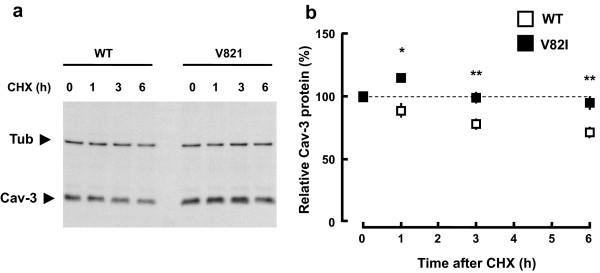
Stability of Cav-3 WT and Cav-3 V82I. Transfected BHK cells were treated with cycloheximide (10 μg/ml; CHX) for the indicated length of time. Cells were then collected in same volumes of lysis buffer and equal volumes of extracts were analyzed by immunoblotting. Representative blot is shown in (a). Levels of residual caveolin-3 at the indicated time points (% of time 0) for Cav-3 WT and Cav-3 V82I are shown in (b). Data are representative of four independent experiments. *, P < 0.05 vs WT at the respective time point; **, P < 0.01 vs WT at the respective time points.